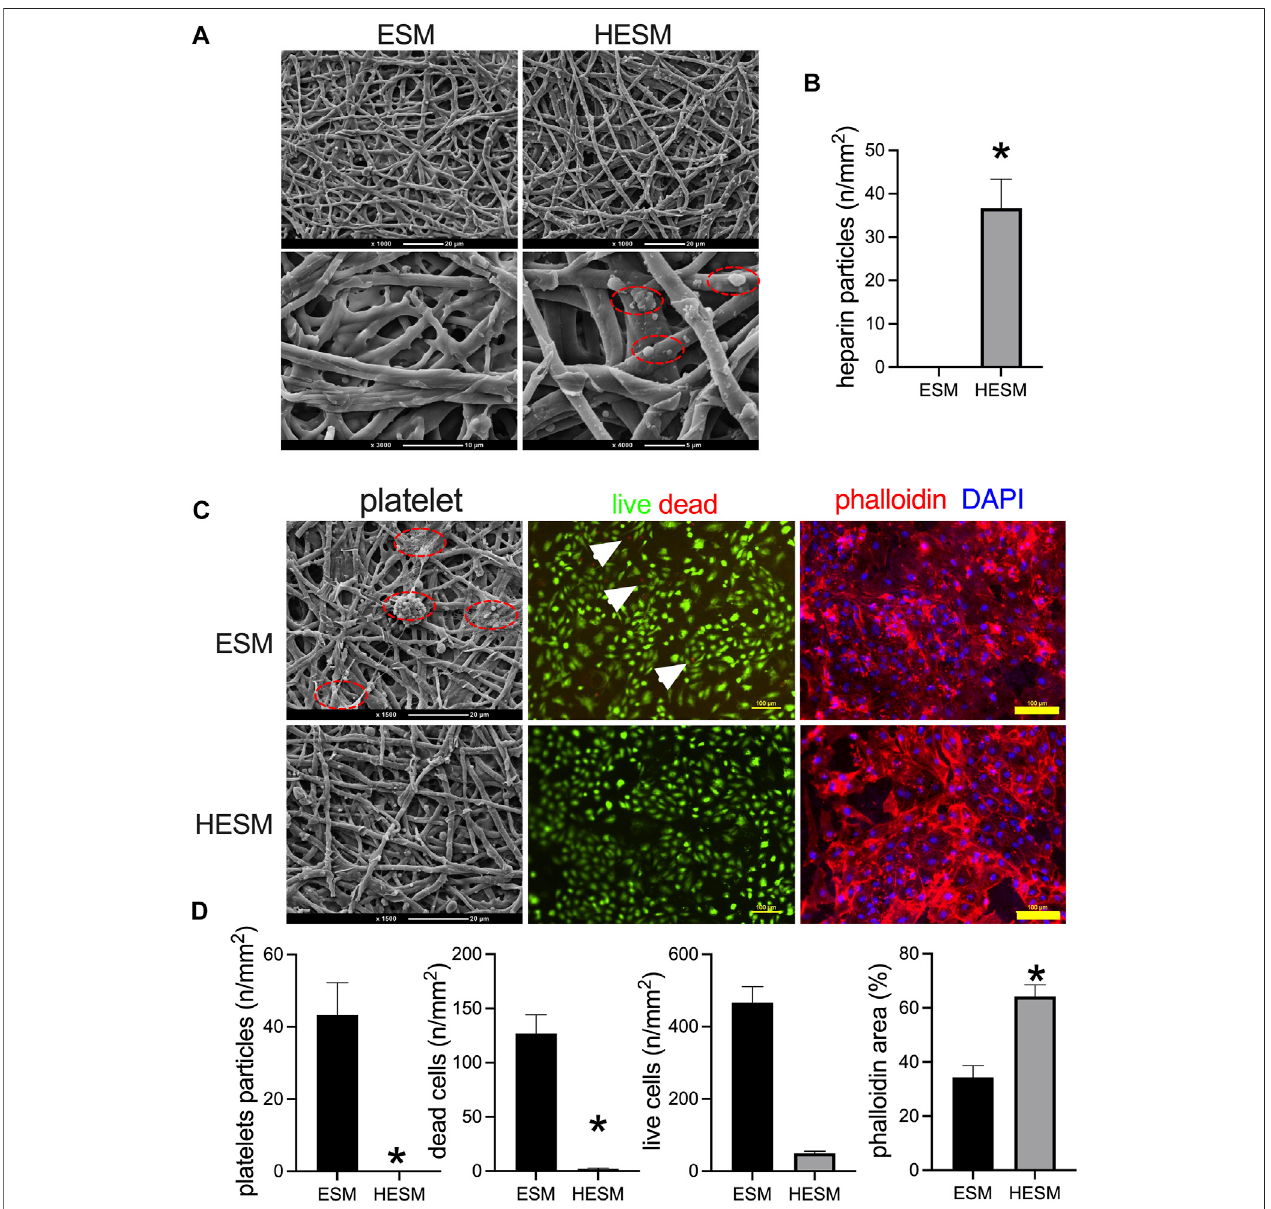
FIGURE 5 | Heparin-coated ESM (HESM) decreases platelets adhesion in vitro . (A) SEM images of ESM and HESM samples; dashed red line circle showing the heparinparticlescoatedontheHESMpatch, n =3. (B) BargraphshowingthenumbersofheparinparticlesonthesurfaceoftheHESMpatch,* p =0.0053, t -test, n =3. (C) SEMimagesofplateletadhesiononthesurfaceoftheESMpatchbutnottheHESMpatch;reddashedlinecircleshowingtheplateletparticles.Fluorescenceimages of HUVECs cultured on ESM and HESM for 7 days, live (green) and dead (red) cells, white arrows show the dead cells; immuno fl uorescence showing the nucleus (blue) and phalloidin (red) of cells; n = 3. (D) Bar graph showing the number of platelet particles (* p = 0.0080, t -test), dead cell numbers (* p = 0.0051, t -test), live cell numbers ( p = 0.6880, t -test), and phalloidin area (* p = 0.0078, t -test) on the surface of the ESM and HESM patches; n =